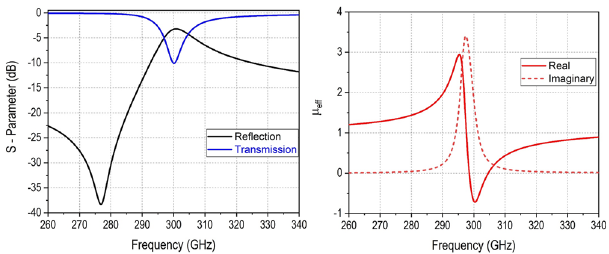
Figure 3. Reflection and transmission coefficients of the MM cell, real and imaginary parts of the estimated effective